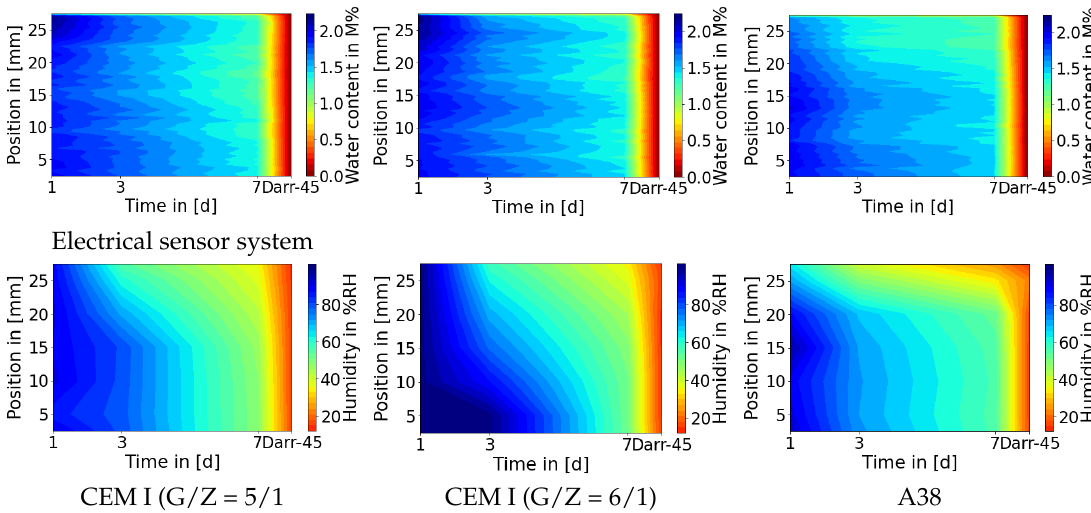
Figure 6. An illustration of the water content over time and location, which resembles the measurements of the electronic sensors which were placed in the sample at different heights. To compensate for the discrepancy in the resolution of the sensors (low, 5 sensors) and NR (high, 200 µ m), the measurement results of the humidity sensors were interpolated. In this illustration averages were calculated to create the NR images, therefore the resolution is reduced to 400 µ m. Colourised subplots visualise the drying characteristics of the samples over time, where blue equals to high moisture content and red to lower values. After seven days of measuring, the samples were dried in order to create the calibration point. At the location ‘d = 8’ on the time-axis, the tick-marker ‘Darr-45’ represents the water content of the dried calibration sample, which explains the high gradient after day 7. The first row of subplots consists of the results of NR; the second row compares these results to the electrical sensor system’s